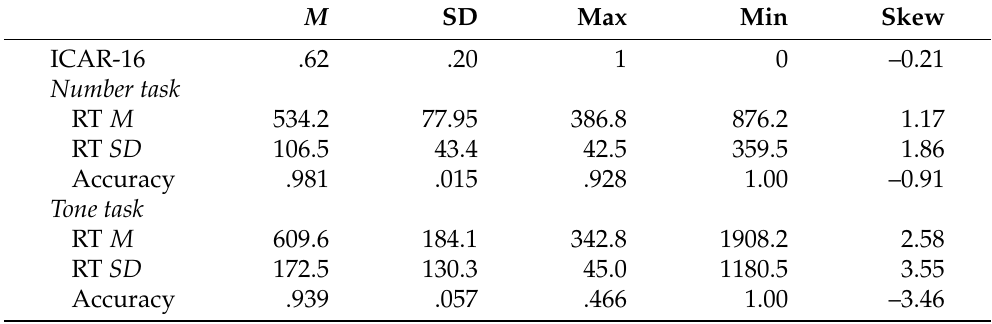
Table 3. Distributional characteristics of cognitive assessment and RT moments in current